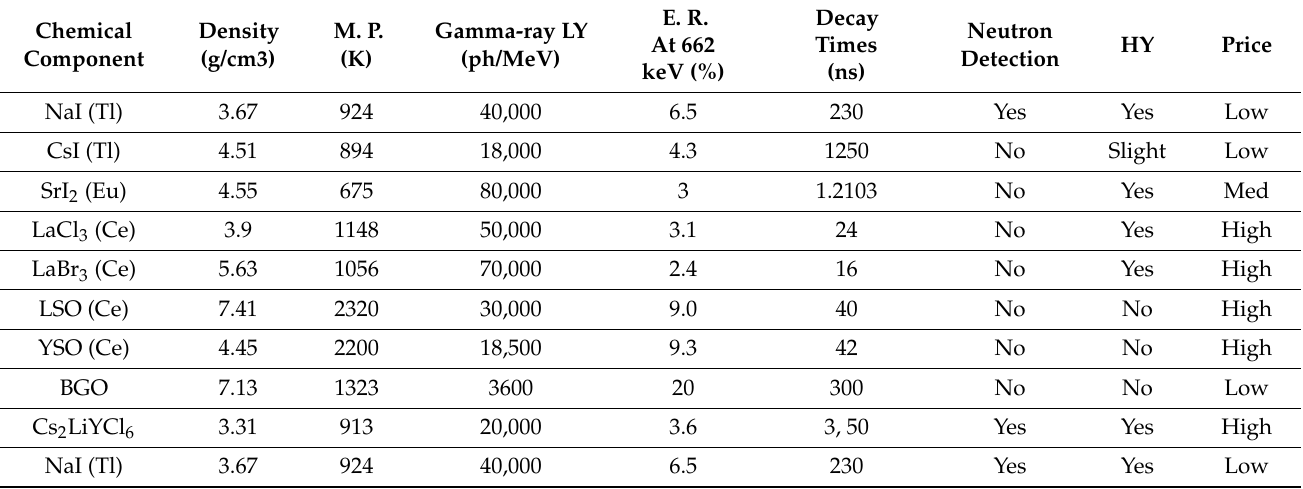
Table 1. The physical and scintillation characteristics of various scintillator crystals. M.P.: melting point; E.R.: energy resolution; HY: